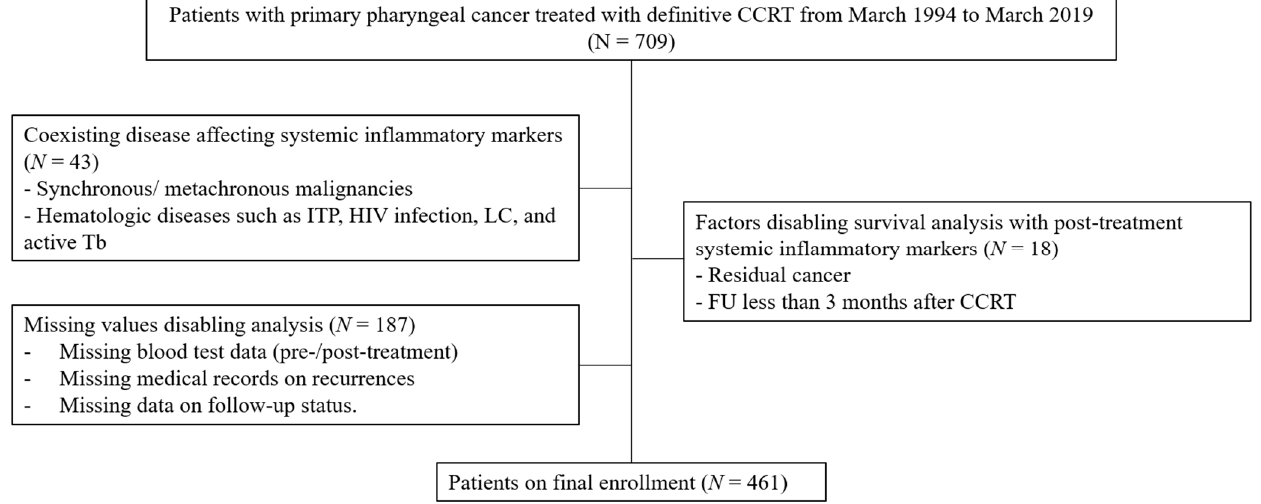
Figure 1. Flowchart of patients’ enrollment. The clinicopathological profiles of the 461 patients are presented in Table 1. The mean age of the patients was 60.24 years (standard deviation, 13.53 years). There were 380 men (82.4%) and 81 women (17.6%). One hundred and forty patients (30.4%) were smokers.